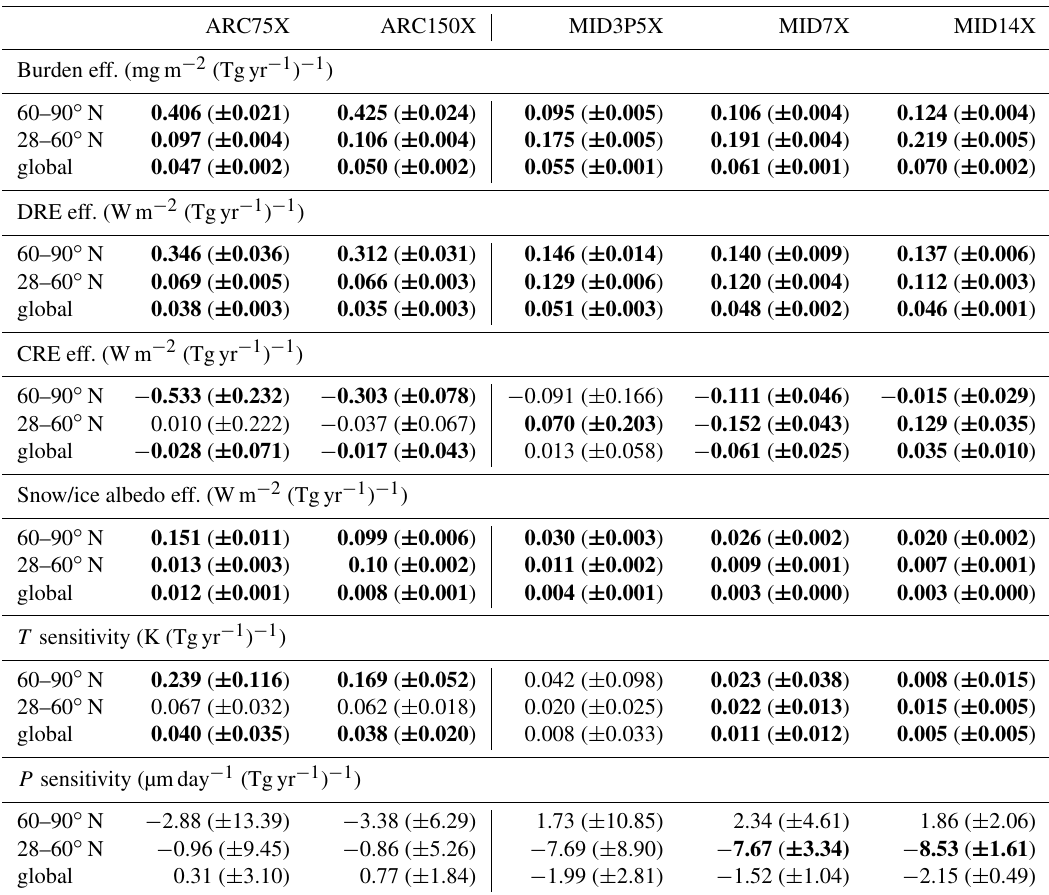
Table 2. BC burden, DRE, CRE, and snow/ice albedo forcing efficiencies, T sensitivity, and P sensitivity over the Arctic (60–90 ◦ N), midlatitudes (28–60 ◦ N), and the globe between perturbed (ARC75X, ARC150X, MID3.5X, MID7X, and MID14X) and PD simulations. 1 σ for 80 annual means is shown in the parentheses. Bold values between two simulations (ARC75X, ARC150X; MID3.5X, MID7X; and MID7X, MID14X) indicates statistically significant changes with 95% confidence from a two-tailed Student’s t